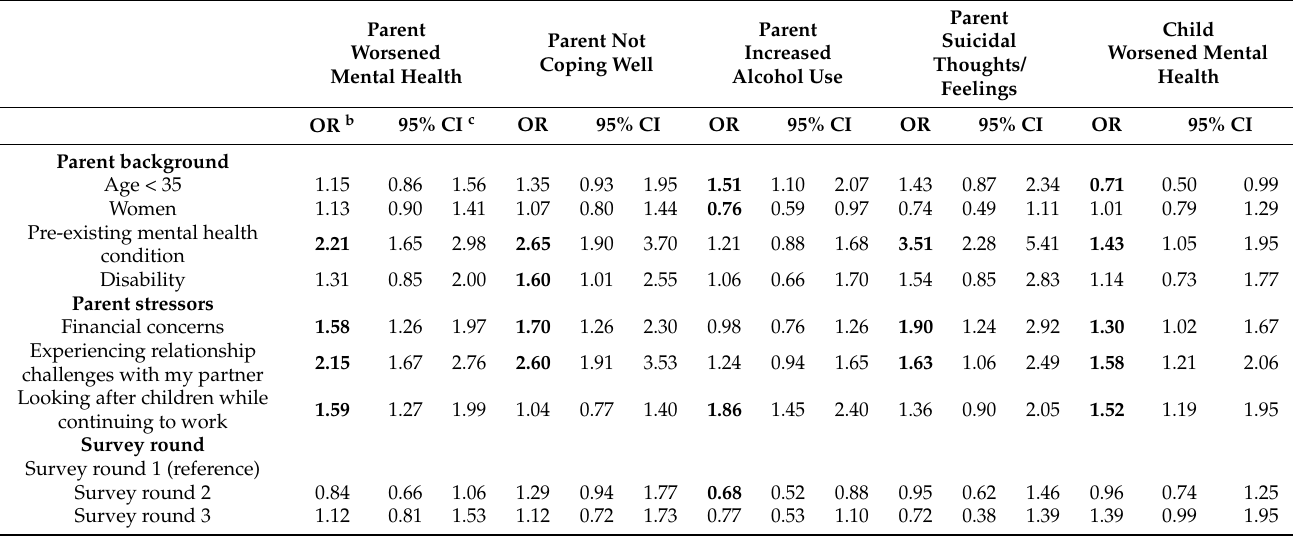
Table 3. Odds ratios of worsened mental health since the onset of the COVID-19 pandemic by parent sociodemographic factors, stressors, and survey round ( n = 1541) a .